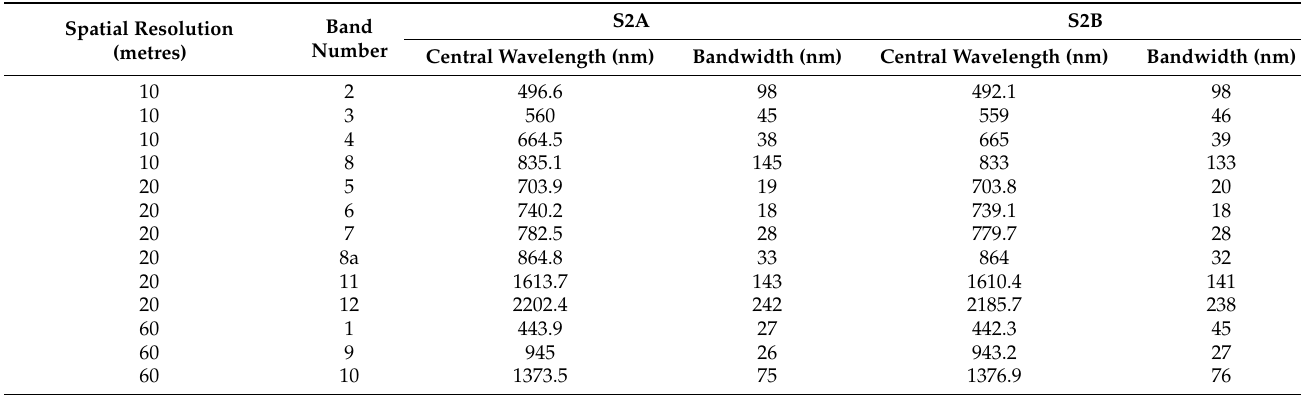
Table A3. Sentinel-2 imager specifications.